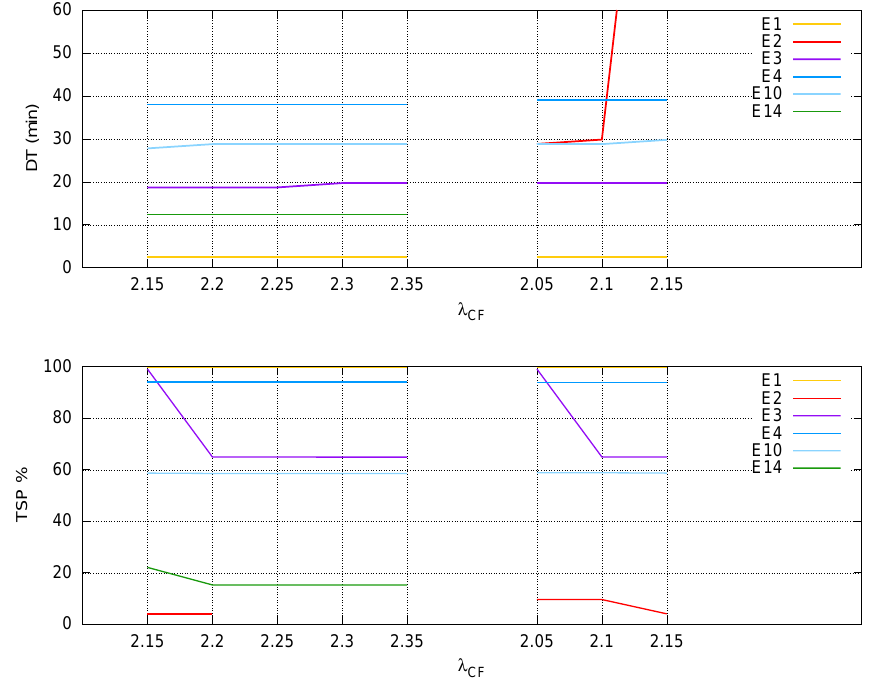
Fig. 7. Comparison of Delay Time (DT) and Tsunami State Duration (TSP) for configurations A3C5 (on the left) and A3C7 (on the right) within the Detection Tsunami Range (DTR(5)). Every event can be identified by a different color.